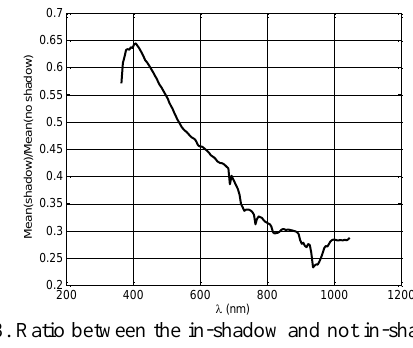
Figure 4. Mean pixel intensity vs. the NTII and wavelength for selected classes of